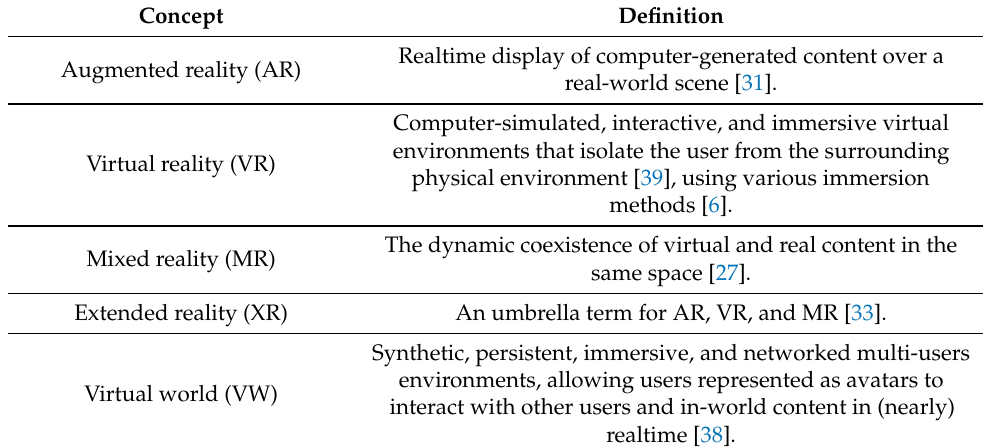
Table 1. Definition of AR, VR, MR, and